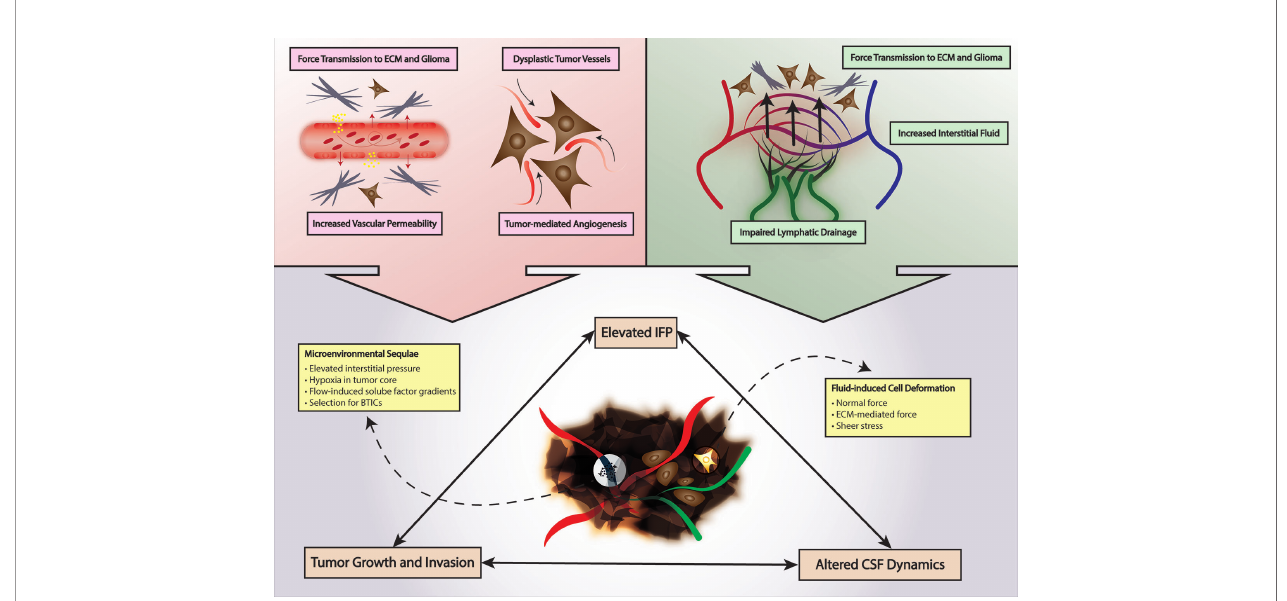
FIGURE 2 | Fluid Mechanics in Glioma. Tumor-mediated angiogenesis and tumor-mediated increased vascular permeability increases interstitial fl uid pressure and force transmission to glioma cells and ECM. Lymphatic insuf fi ciency also contributes to increased interstitial fl uid pressure. Increased mechanical stimuli from elevated interstitial fl uid pressure can promote a tumor environment selective for BTICs and alter CSF dynamics. CSF, cerebrospinal fl uid; ECM, extracellular matrix; BTICs, brain tumor-initiating cells; IFP, interstitial fl uid